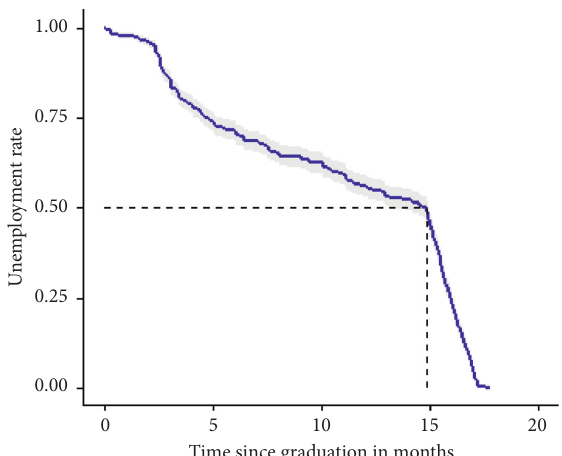
Figure 1: Kaplan–Meier curve for the waiting time until the first employment.